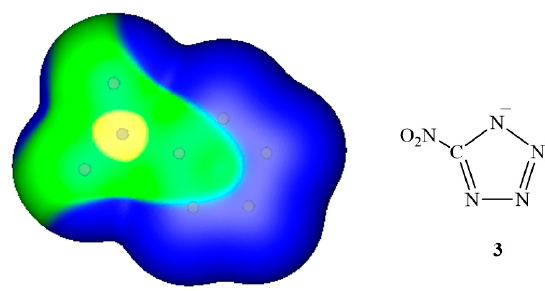
Figures 3 and 4 display the electrostatic potentials on the 0.001 au surfaces of the resulting 5-nitrotetrazolate anion ( 3 ) and 3-nitro-1,2,4-triazolate anion ( 4 ).